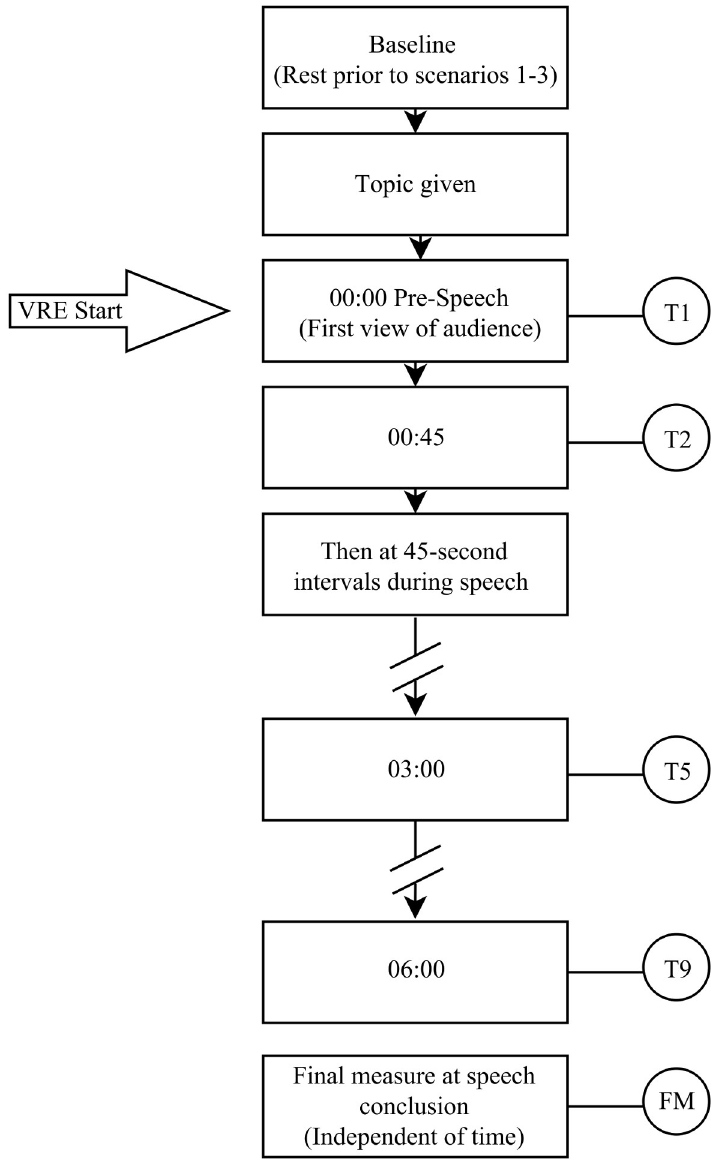
Fig 4. Within-scenario heart rate and Subjective Units of Discomfort Scale measure intervals